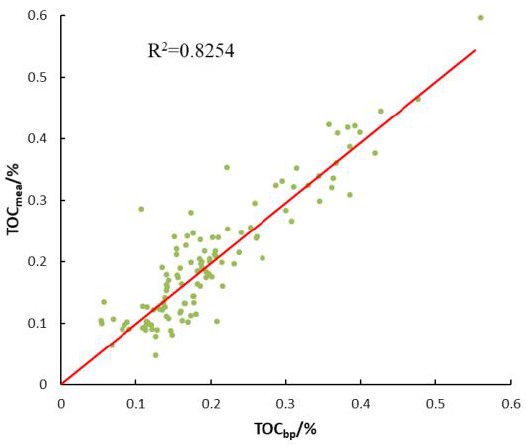
Figure 9. Scatter plot of predicted TOC and measured TOC by neural network.